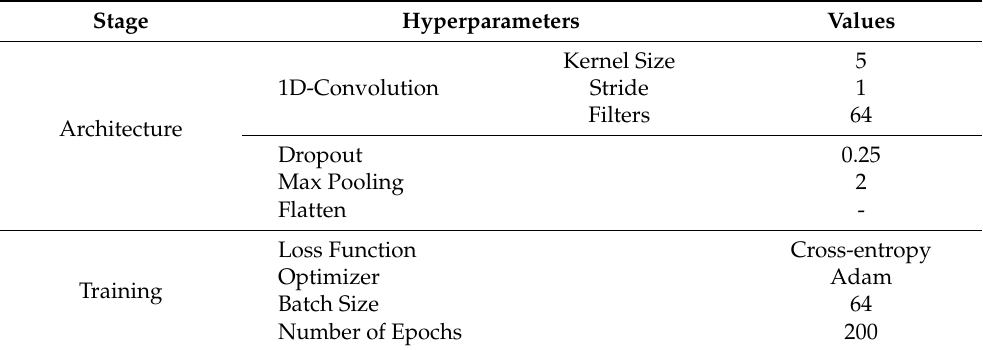
Table A1. The summary of hyperparameters for the CNN network used in this work.